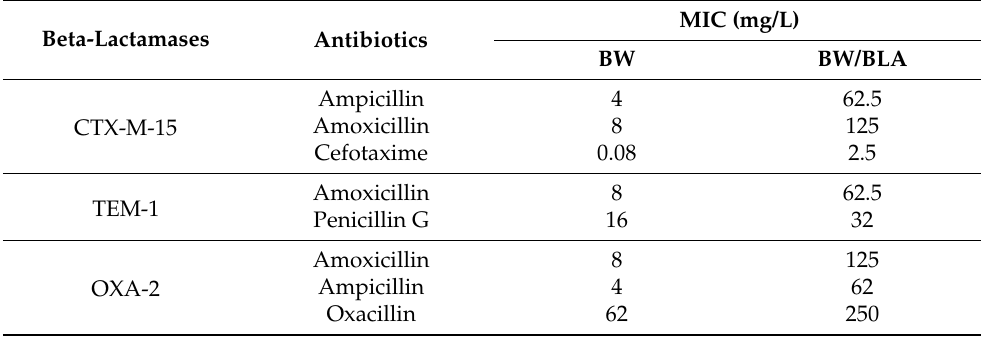
Table 2. Beta-lactamase expression established by their beta-lactam resistance pattern in wild type E. coli